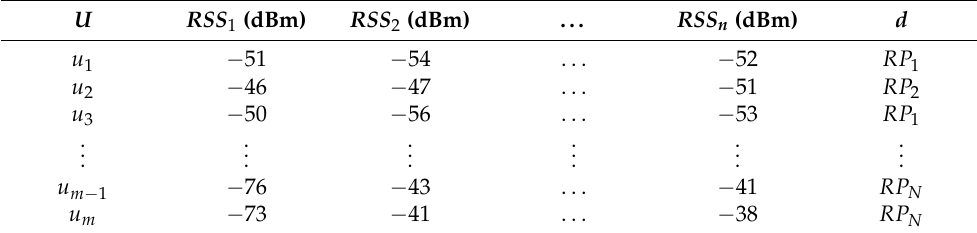
Table 1. The structure of the decision